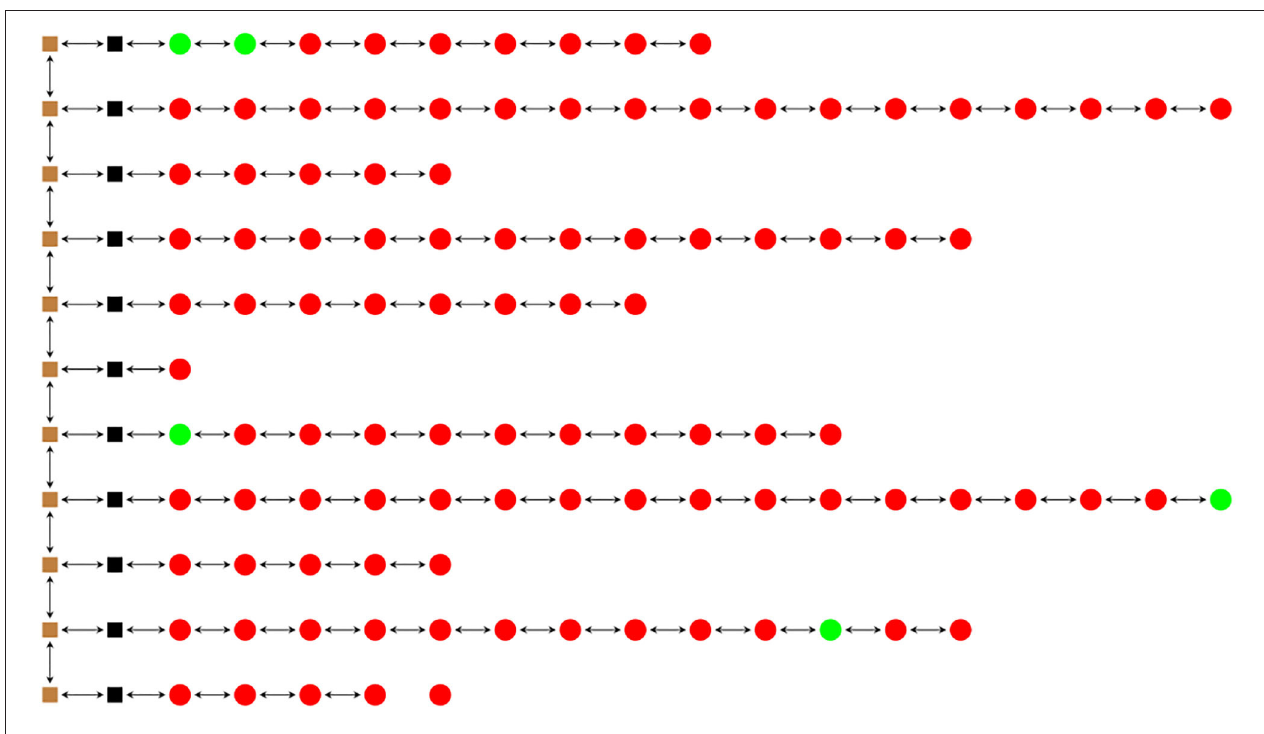
FIGURE 5 | Feeder diagram.